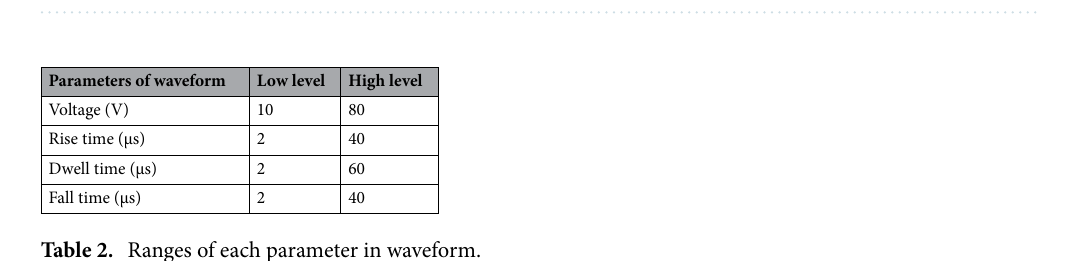
Table 1. Summary of fluid properties for each ink, together with dimensionless number Z.